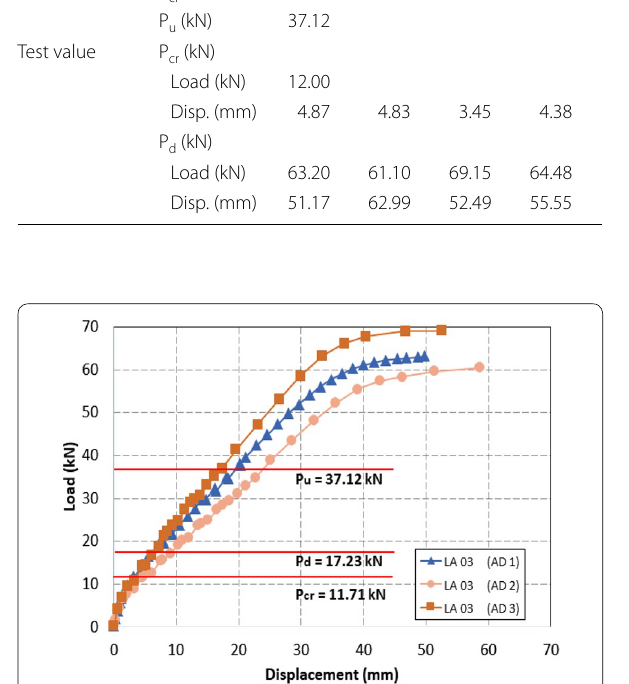
Fig. 6 AD center point load–displacement curve.